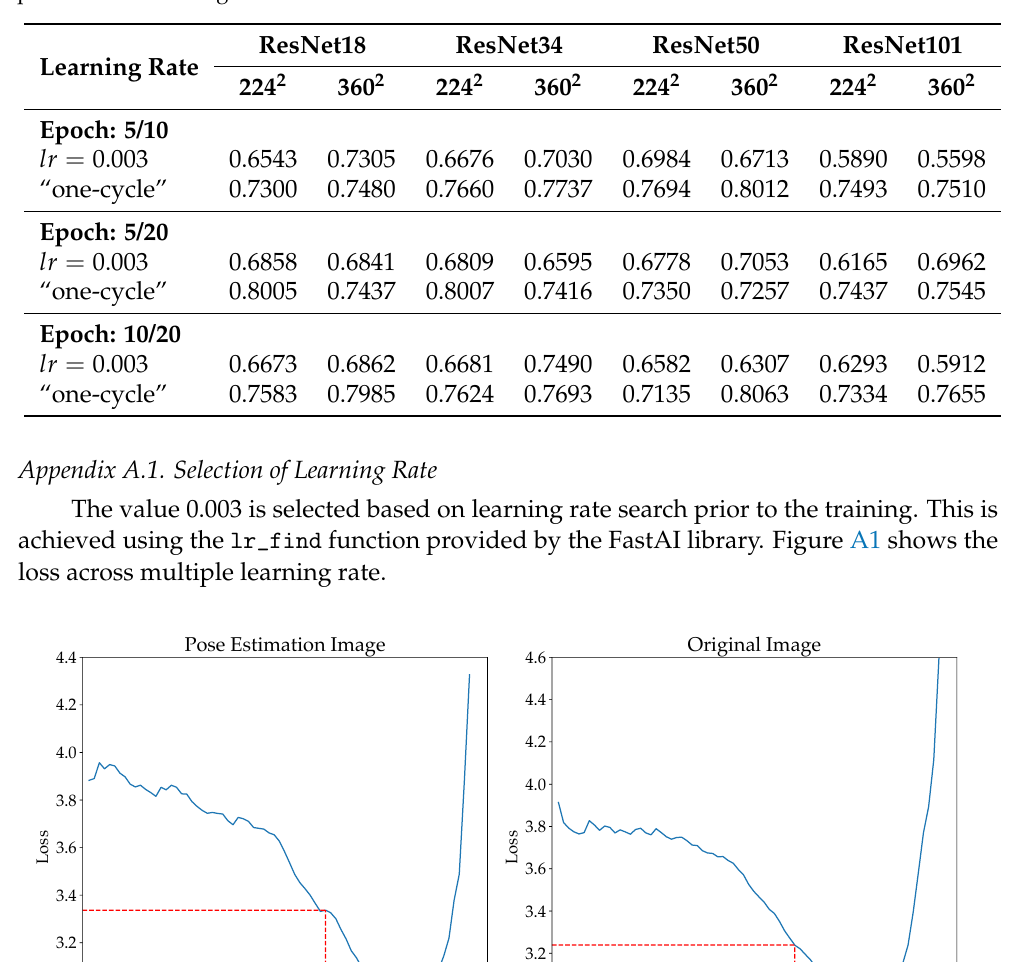
Table A2. F1 Score of different ResNet with and without discriminative learning rate scheduling on pose estimation image dataset